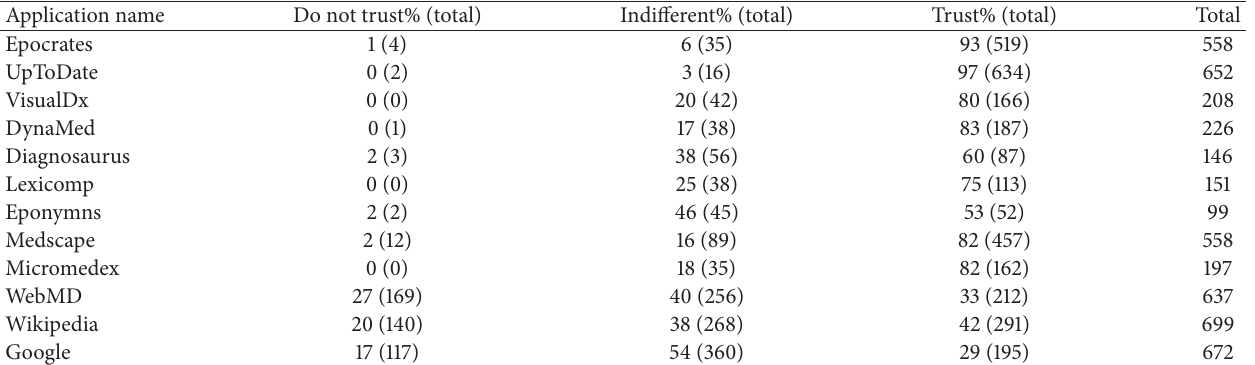
Table 2: Perceptions of medical app reliability amongst US medical students ( 𝑁 = 731 ).